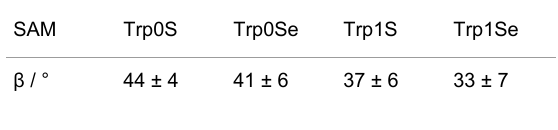
Table 3: Tilt angles β of the molecular axes of the triptycene units ob- tained from the C 1s- π 1 * resonance in the NEXAFS spectra of Trp0S, Trp0Se, Trp1S and Trp1Se-SAMs on Au(111). Errors are given on 2 σ